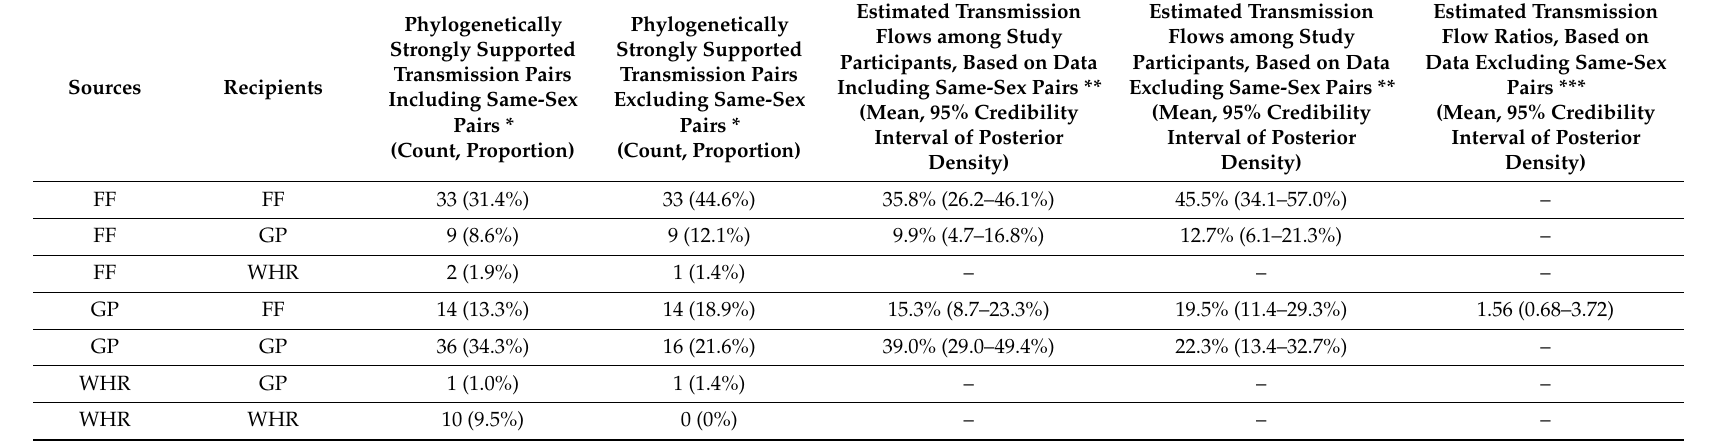
Table 2. Phylogenetically observed HIV-1 transmission